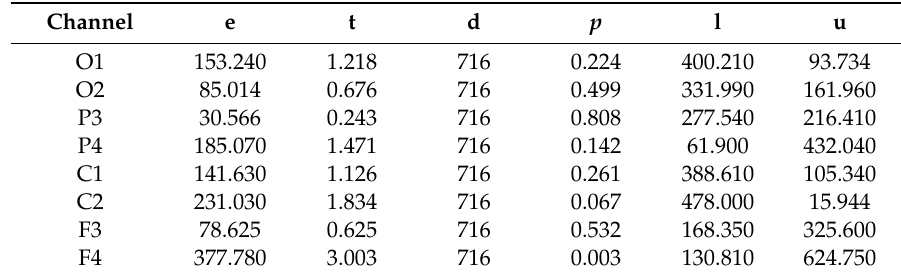
Table 3. Coe ffi cient estimates resulting from the GLMM analysis of SSVEP amplitude for the eight recording channels. See text and Table 1 for abbreviations.